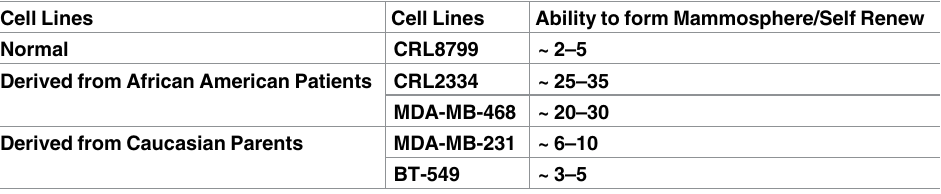
Table 1. Differencesin the ability of CSCs to form mammospheres